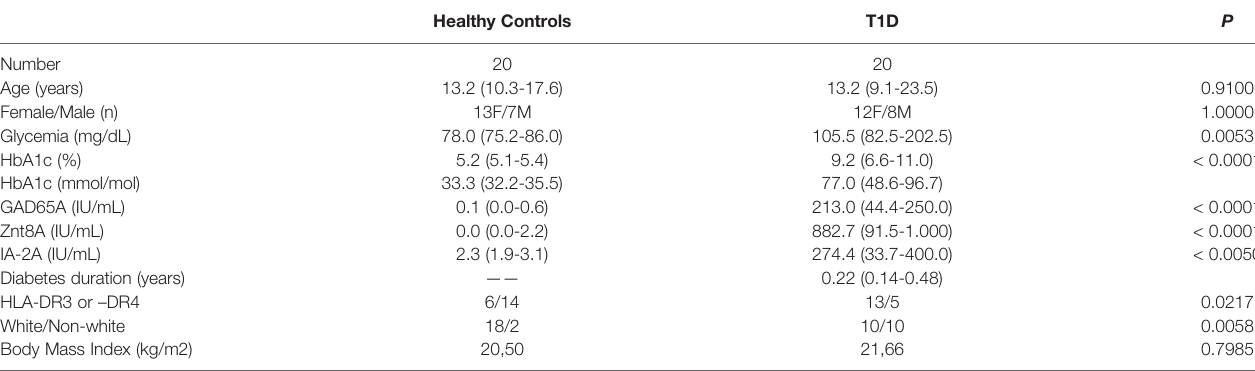
TABLE 1 | Clinical characteristics of patients with type 1 diabetes (T1D) and healthy controls.